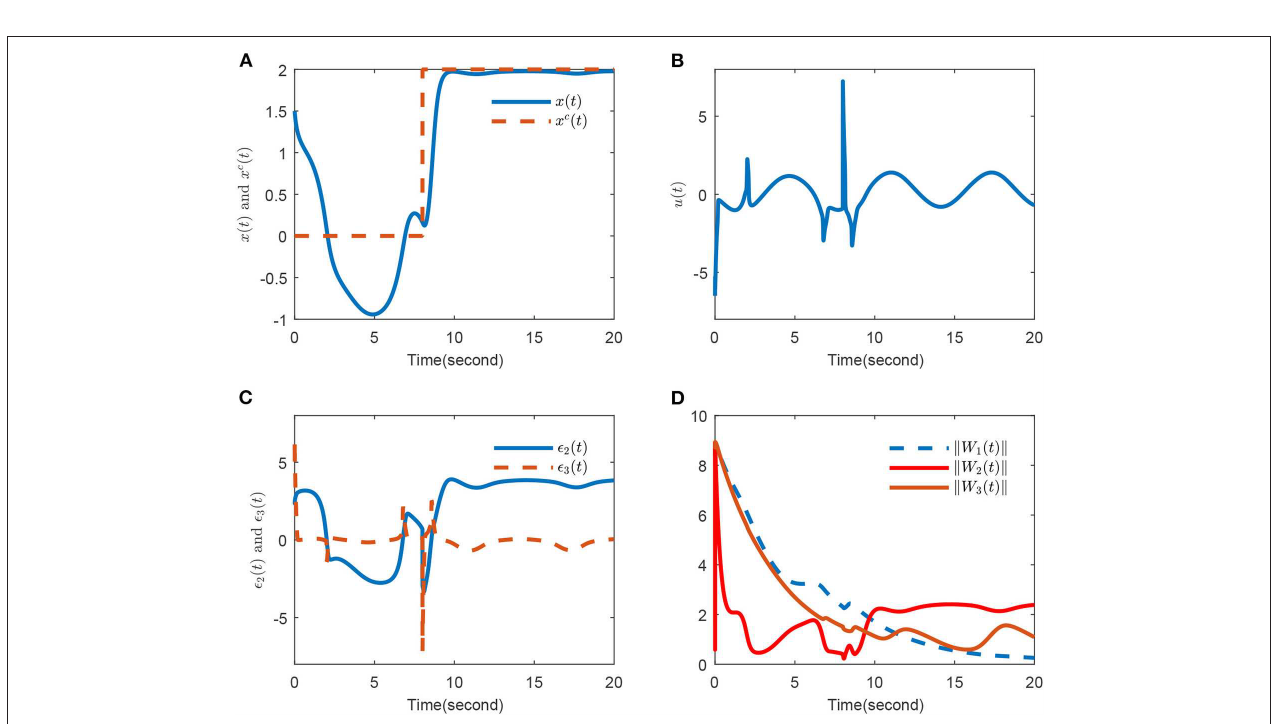
W 1 ( t ) W 2 ( t ) W 3 ( t ) , and . k k k k k k